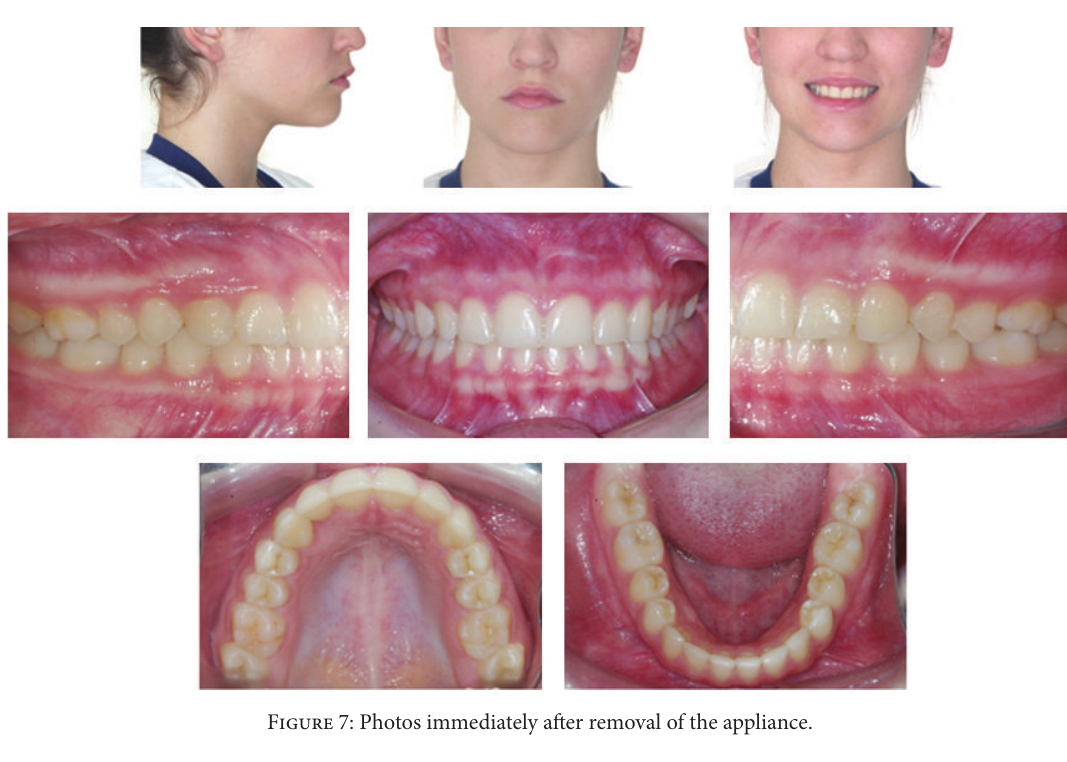
Figure 7: Photos immediately after removal of the appliance.